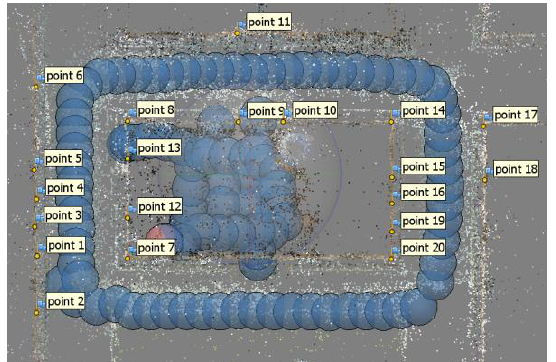
Figure 2. Some examples of the 104 images acquired inside and outside a building.